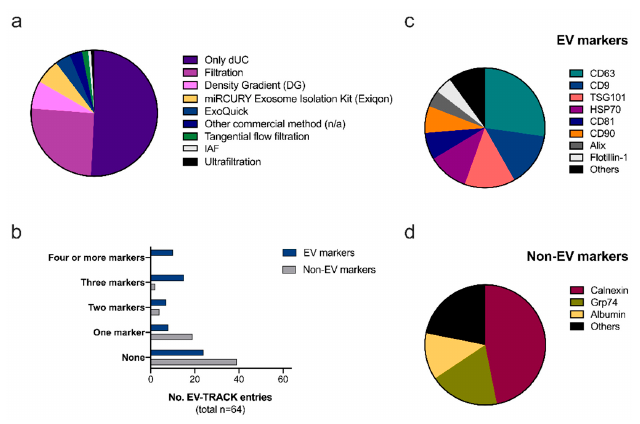
Figure 2. Overview of EV-TRACK adipose-related entries. Records for “adipose”, “adipose tissue” and “adipocyte” search terms on the EV-TRACK knowledge database were combined and